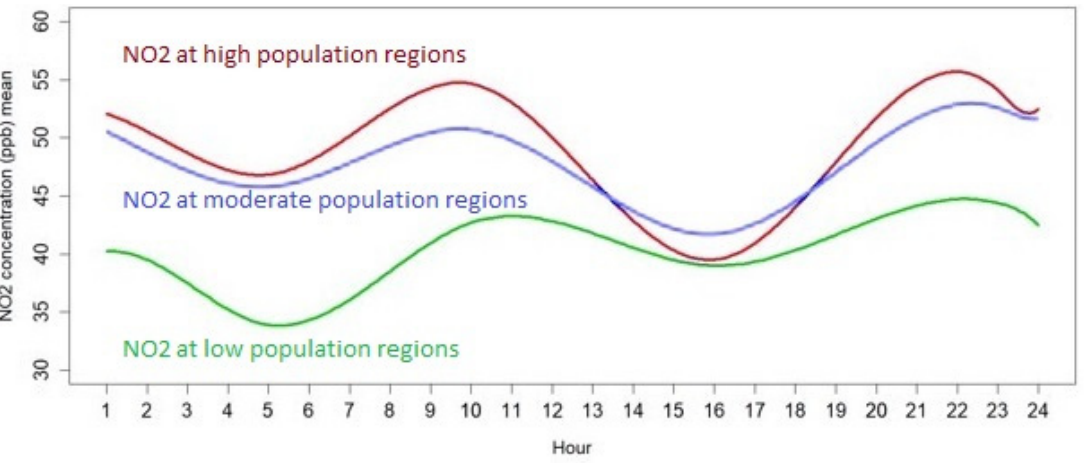
Figure 6. The prediction of the mean NO 2 diurnal curves in low population density areas (green curve), moderate population density areas (blue curve), and high population density areas (red curve).